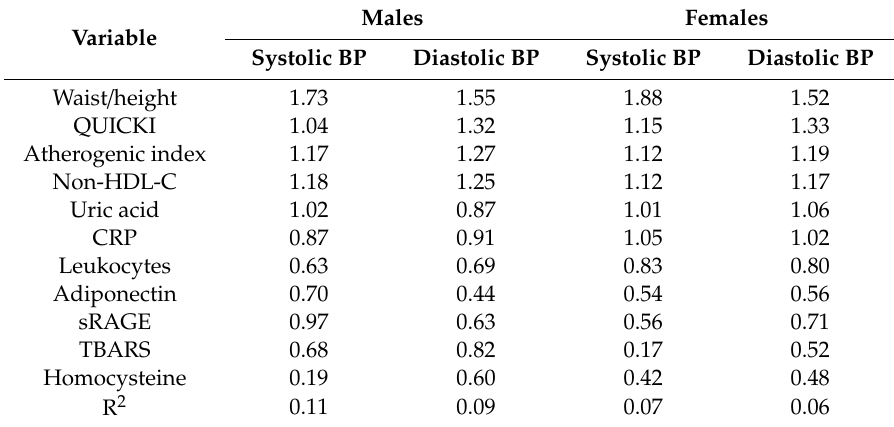
Table 3. Multivariate regression on systolic and diastolic blood pressure using the Orthogonal Projections to Latent Structures model in males and